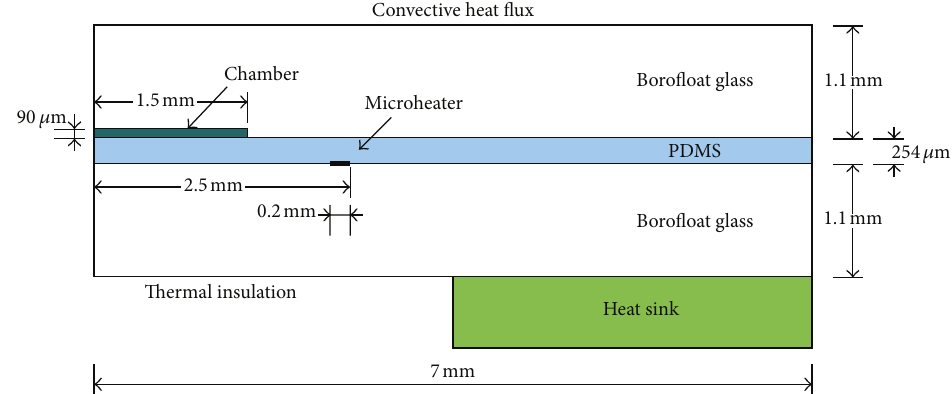
Figure 3: Cross-section view and dimensions of PCR LOC microchip. Due to the axisymmetric geometry of the chip, only half the chip is shown. The axis of symmetry is along the left vertical side. A circular hole is cut in the middle of the heatsink to provide thermal insulation under the heater and chamber. Heat is lost by free convection on the top and by conduction through the heatsink